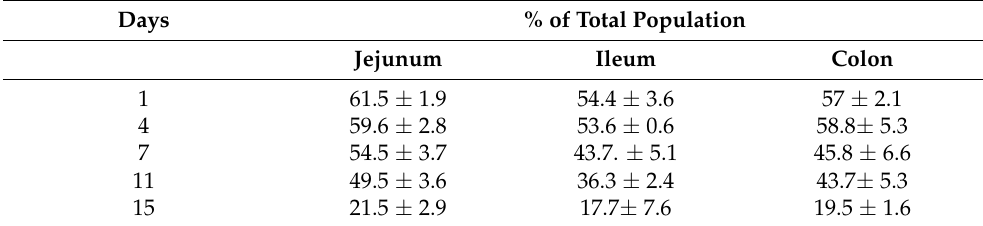
Each sample was repeated three times, and three chicks (n = 3) were sacrificed each time.